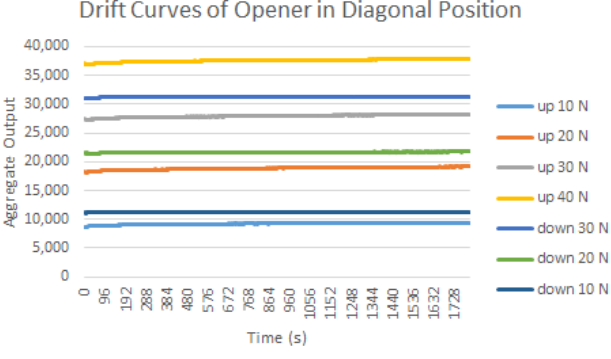
Figure 9. Drift of the Aggregate Output registered by the commercial sensor and the “opener” object atop for different force increments and